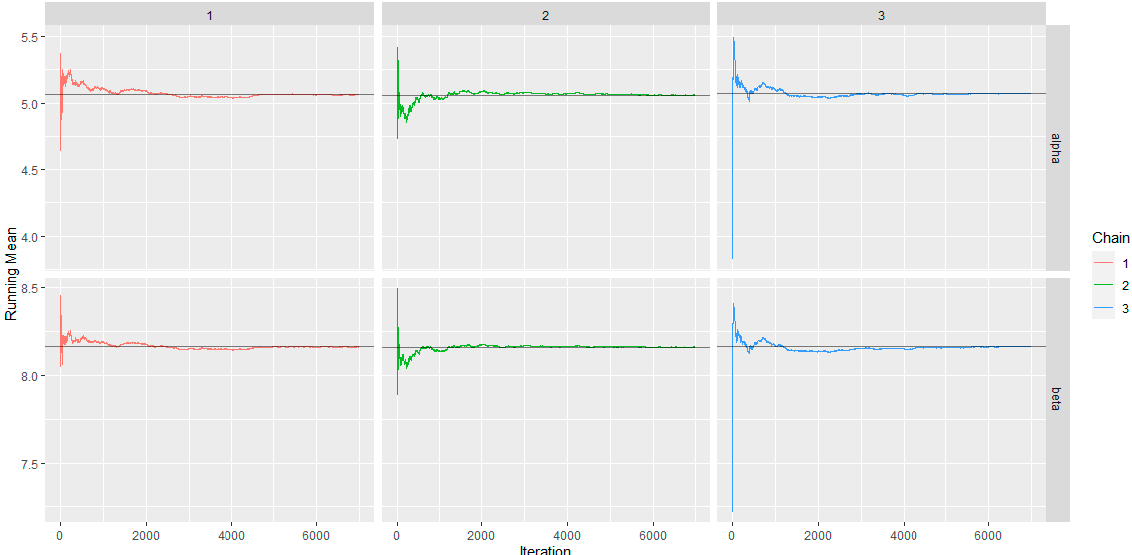
Figure 13. The AP distribution posterior parameters autocorrelation plots. 7. Regression Models In this section, the quantile and modal regression models are developed for investi- gating the relationship between a dependent variable and a set of independent variable (s). 7.1. Quantile Regression Model When investigating the influence of covariates on a skewed, bounded response vari- able, the beta regression model cannot produce reliable results since it models the condi- tional mean of the response variable. This is because the mean is not an appropriate